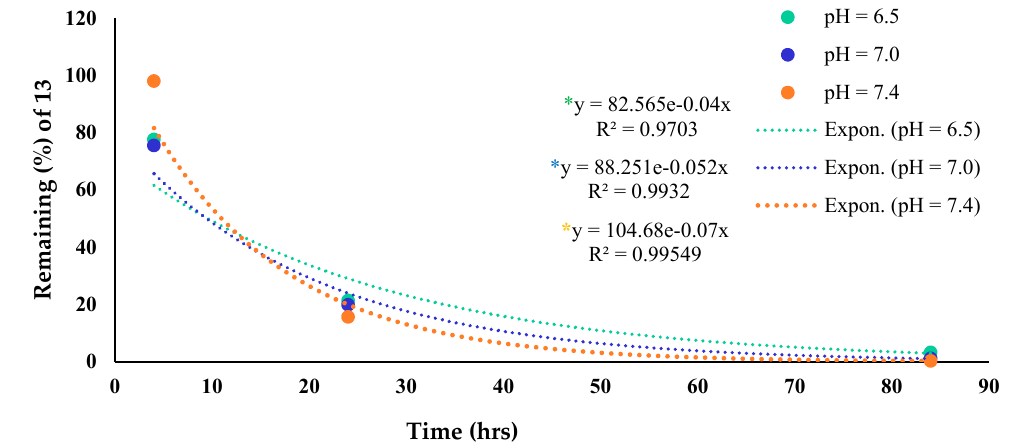
Figure 2. Conjugate 13 in PBS at different pH. The percent remaining of conjugate 13 was quantified using the area under the curve (AUC) in analytical HPLC.